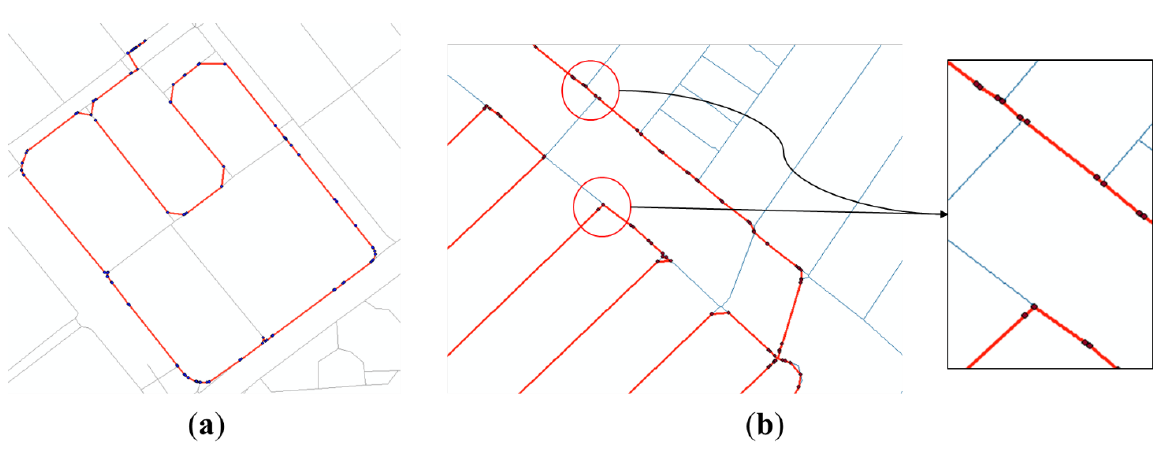
Figure 12. Modified solution after resolving errors (thin lines refer to existing PND, and thick lines refer to the initial solution of the significant points): ( a ) Example of errors on dual-lined segments; ( b ) Examples of errors near the